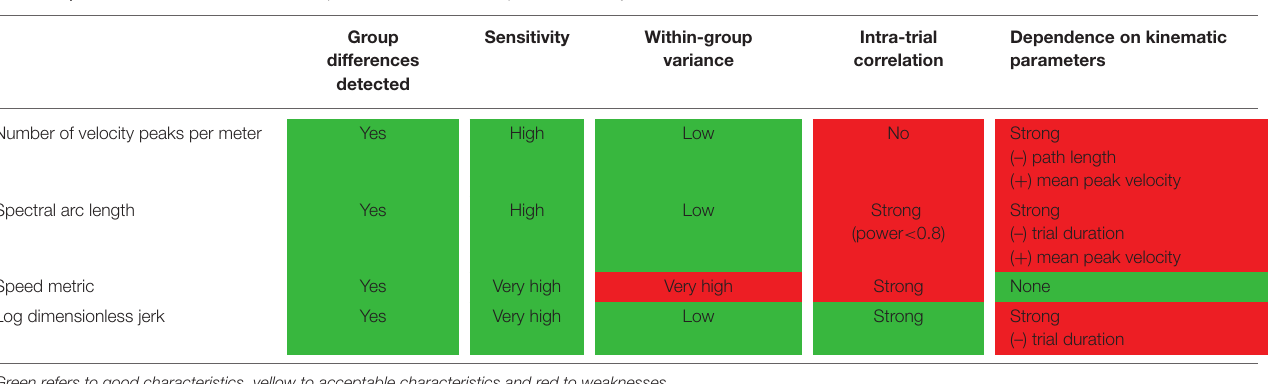
TABLE 6 | Color-coded overview of the interpreted outcomes of the parameter